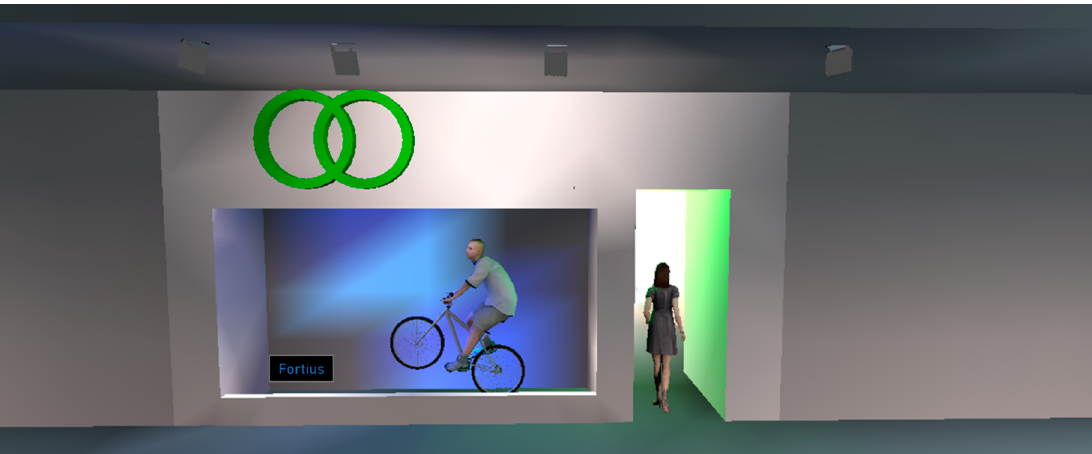
Figure 37. Fast communication at a glass case indicating the Olympic motto—Scene 3.